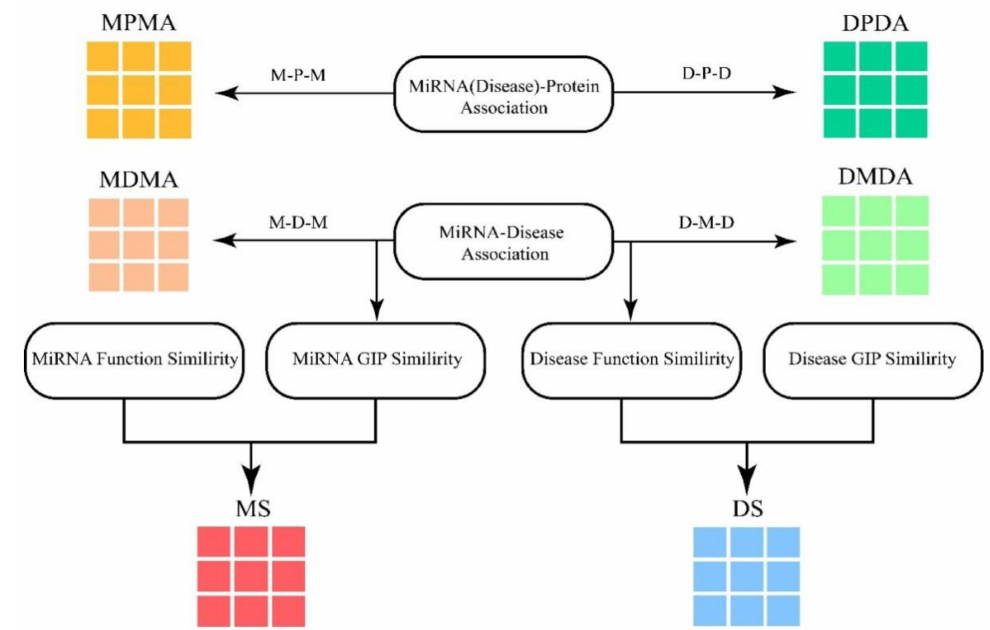
Figure 11. The construction of module. MPMA and MDMA are miRNA adjacent matrices based on proteins and diseases respectively. DPDA and DMDA are disease adjacent matrices based on proteins and diseases respectively. MS and DS are the similarity matrices of miRNAs and diseases